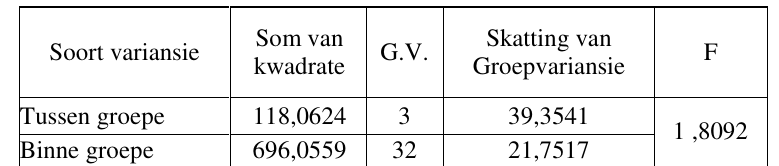
VARIANSIEONTLEDING VAN GELYKE LUIDHEIDSWAARDES OP DIE 95 DB